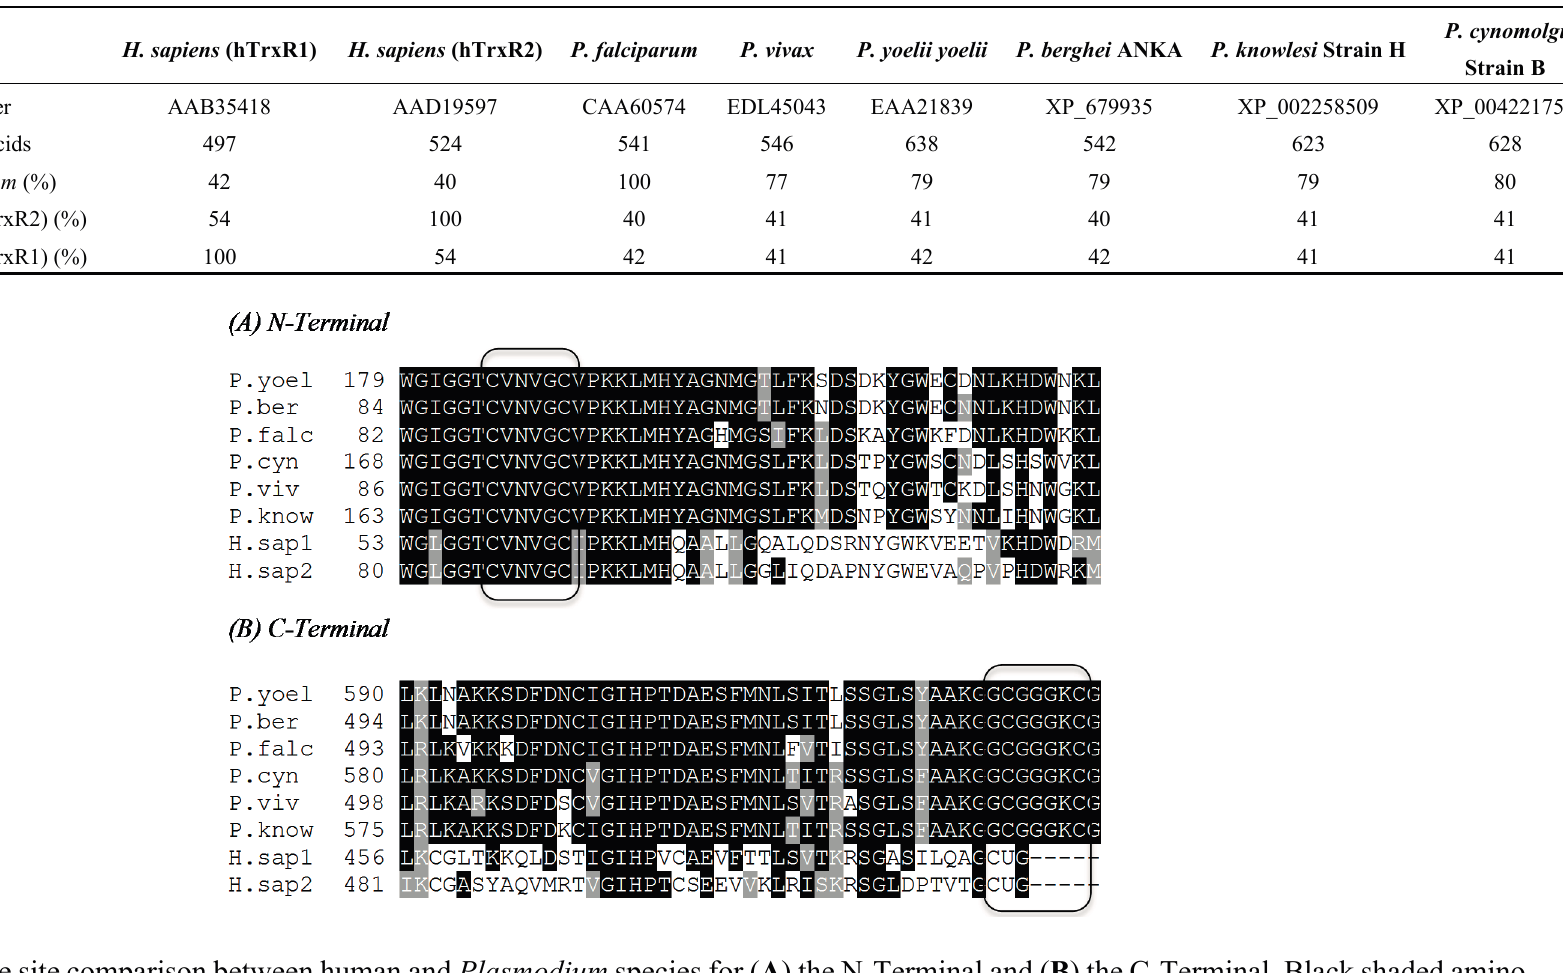
Figure 2. Active site comparison between human and Plasmodium species for ( A ) the N-Terminal and ( B ) the C-Terminal. Black shaded amino acids represent identity with the corresponding black shaded amino acids of other species’ TrxR while grey represents amino acids with similar properties and no shading represent no identity. The figure was generated with ClustalW2 MSA (Multiple Sequence Alignment)